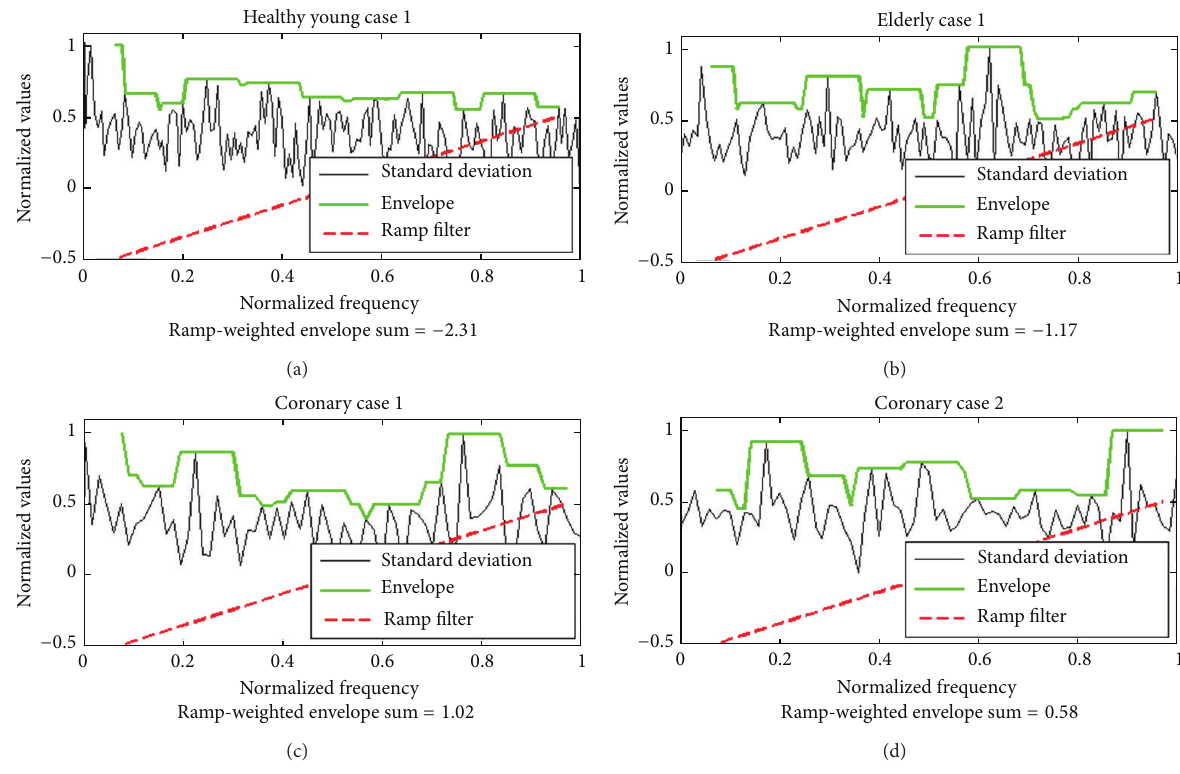
Figure 16: The plots show the standard deviation curves and the corresponding envelope curves for the cases presented in Figure 15. For each plot, the normalized sum of the areas under the envelope curve weighted by a ramp filter is also presented.